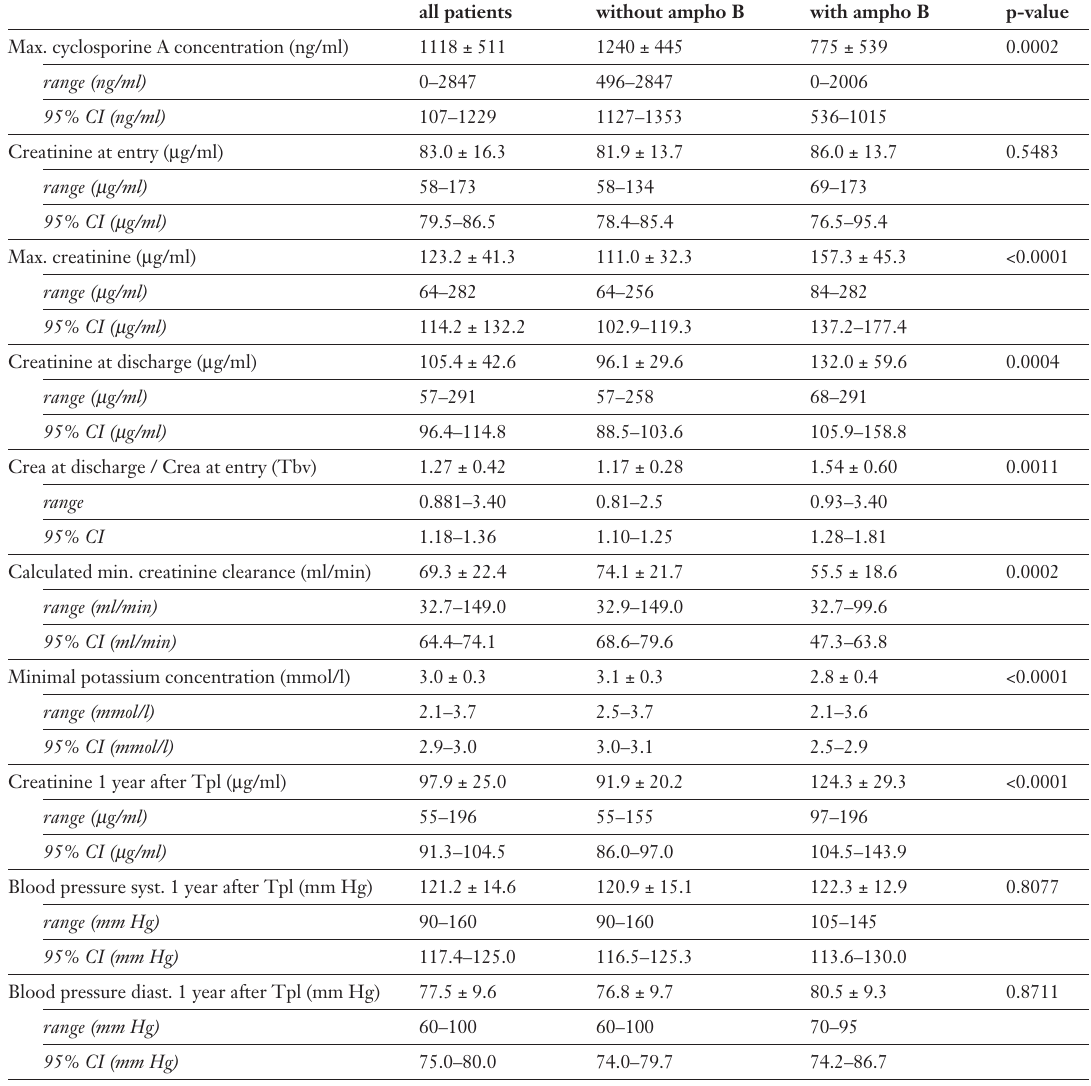
Table 3 Results of all patients compared to treat- ment group with and without ampho- tericin